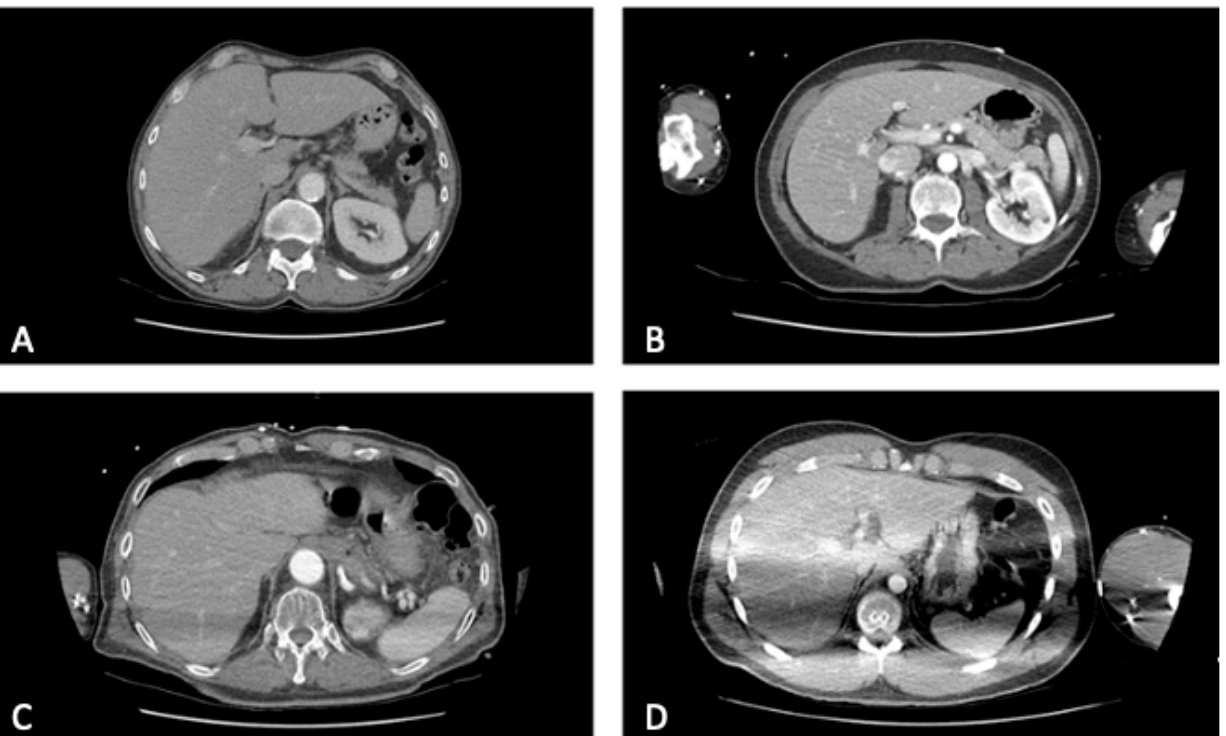
Figure 2. Axial contrast-enhanced CT images of the upper abdomen representing examples of the evaluation of the subjective image quality: ( A ) no artifacts resulting from the arms (score = 1), ( B ) artifacts without impairment of the image quality (score = 2), ( C ) artifacts with a moderate impairment (score = 3), ( D ) massive artifacts (score = 4).